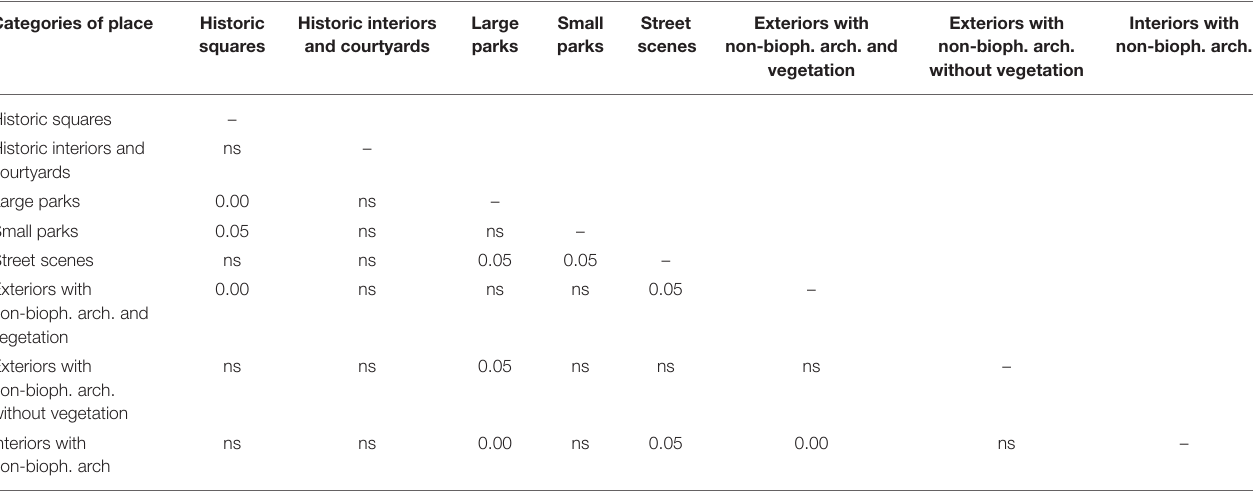
TABLE 5 | Comparisons of olfactory pleasantness scores across the settings ( N = 470, pairwise comparison p -values). Categories of place Interiors with